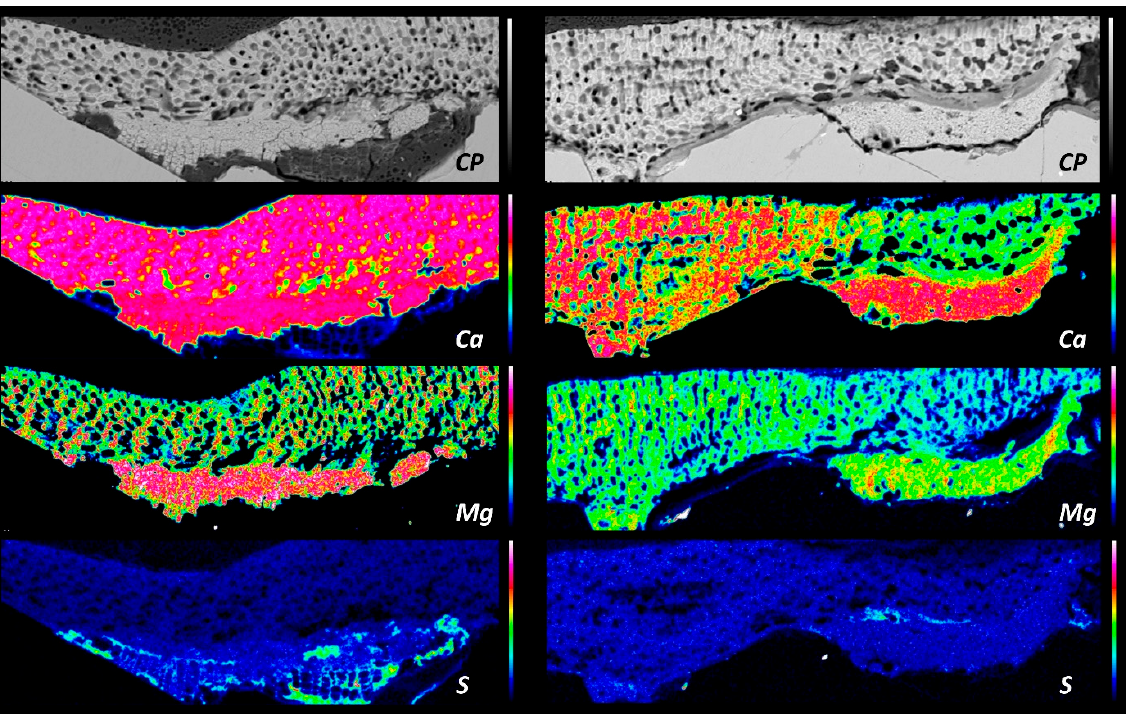
Figure 8. EMP-maps 1 (left) and 2 (right) detailing parts of the ontogenetic transect in T. antarcticum . Each image is showing a compound image (CP) similar to a BSE-image, as well as semiquantitative distribution maps for Ca, Mg and S. Sulfur is tied to the organic rich basal thallus part and enriched at the organic cell walls. Mg is tied to the high-Mg calcite of the cemented cell walls. Spatial resolution 1 × 1 µm, map dimensions 500 × 150 µm. Color scales (map 2/map 3): CP 500–1600 cps/450–1850 cps, Mg 0–120 cps/20–85 cps, Ca 500–825 cps/0–900 cps, S 0–100 cps/0–162 cps.